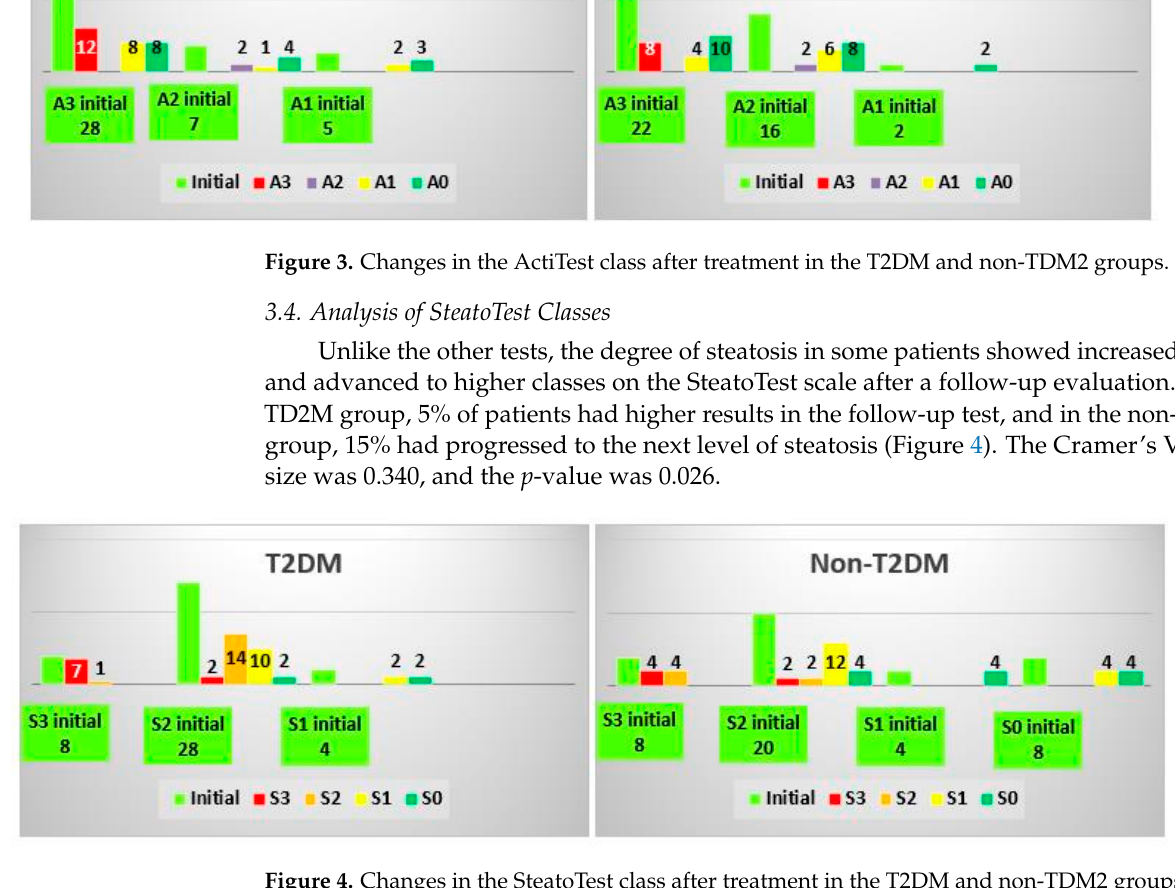
Figure 6. Changes in the AshTest class after treatment in the T2DM and non-TDM2 groups.